Question: Briefly state, in one sentence, what is plotted here.
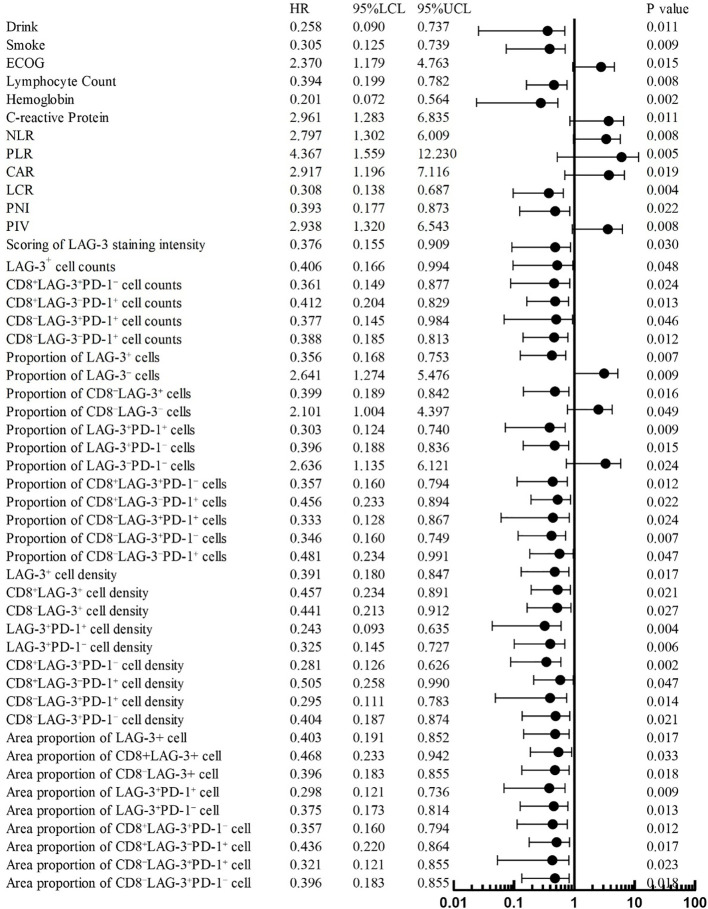
Answer: Forest plot of univariate Cox regression analysis for OS in hepatocellular carcinoma patients receiving targeted combined immunotherapy.